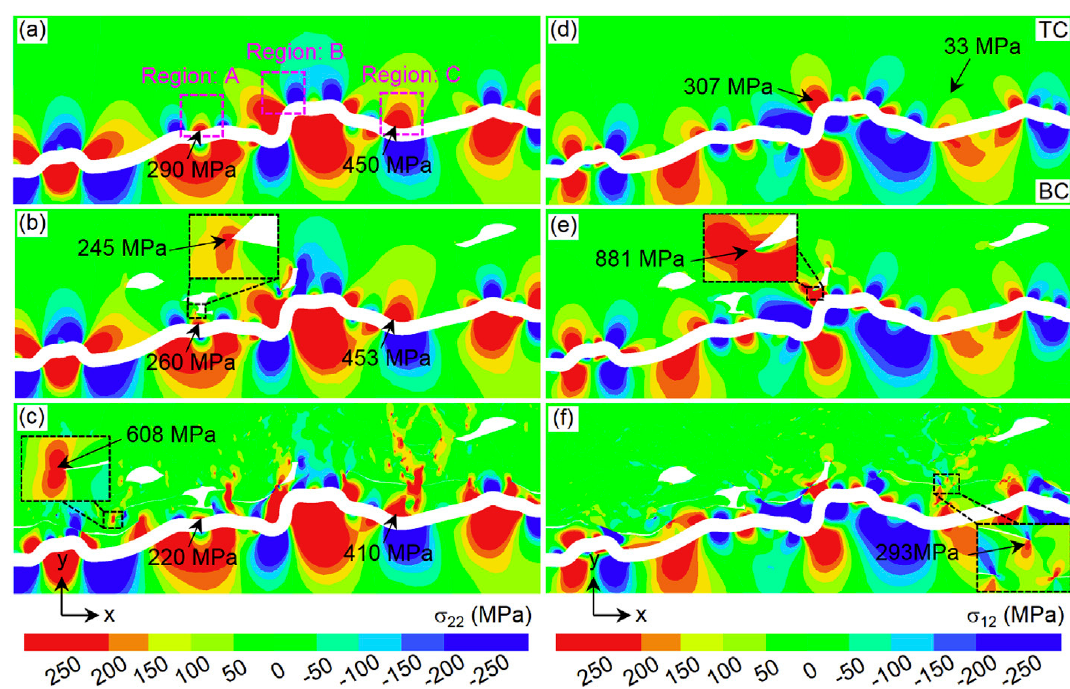
Figure 10. ( a – c ) shows the distribution of the normal stress σ 22 at room temperature after 100 cycles in the defect-free model, porous model, and lamellar model, respectively. Similarly, ( d – f ) shows the shear stress σ 12 distribution in the corresponding models. Reprinted with permission from [36]; Copyright 2019 Elsevier.